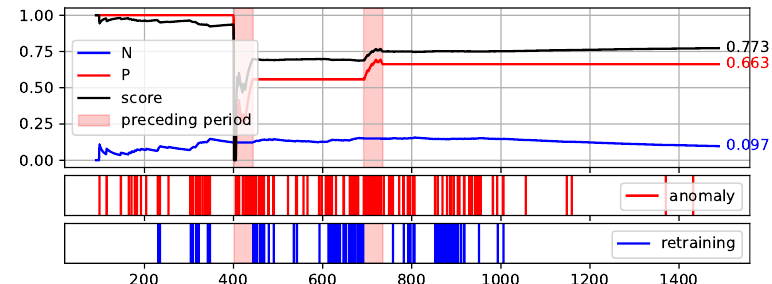
Figure 8. Plot of the values of each measure (P, N, and Score) over consecutive aggregation windows for HDBSCAN execution on the NW-10 data set.